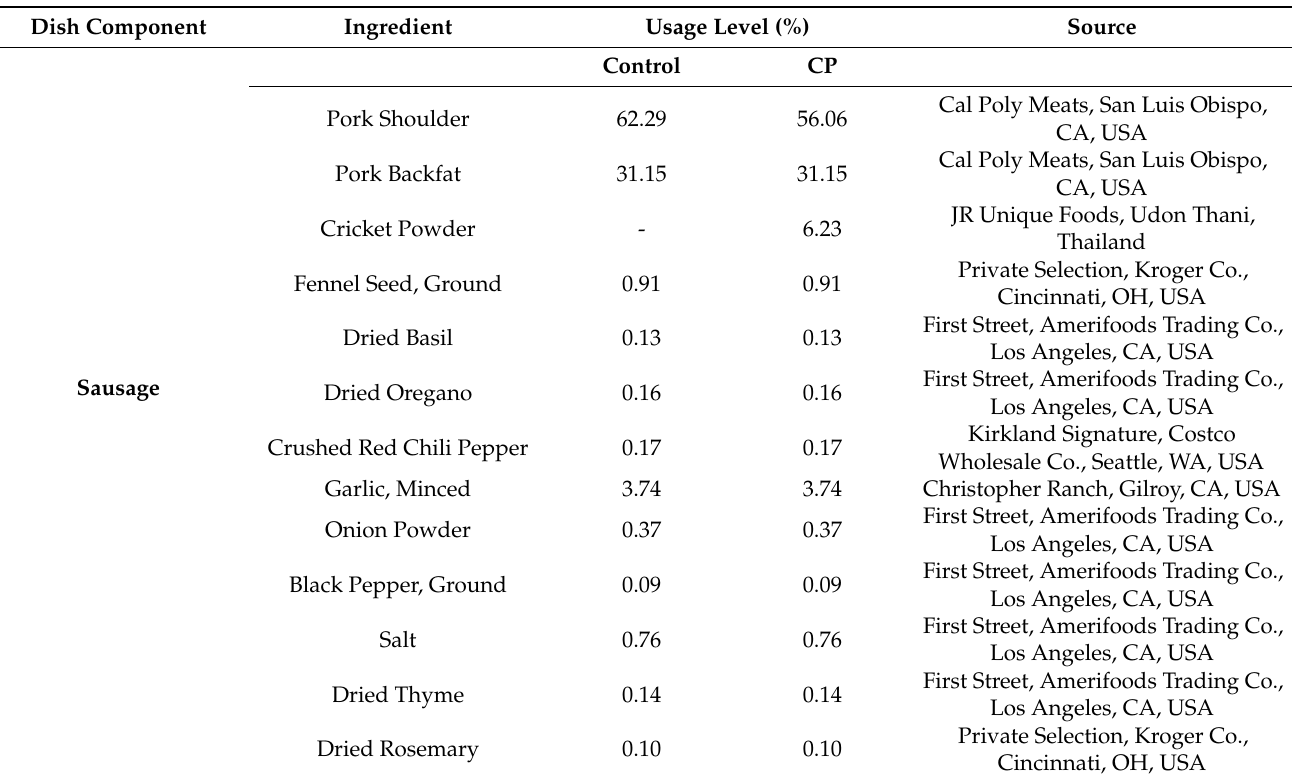
Figure A1. Sausage bruschetta appetizer presented to participants for product evaluation. ( a ) Sausage bruschetta contained the Control sausage used in the study and ( b ) the sausage bruschetta contained the CP sausage. Table A1. Ingredients used and their sources for the Sausage with Peppers and Onions Bruschetta. The sausage component shows the formulations for both the Control and CP versions. Usage levels (%) shown are the percentages used for each dish component. Percentages were rounded to the nearest hundredths.